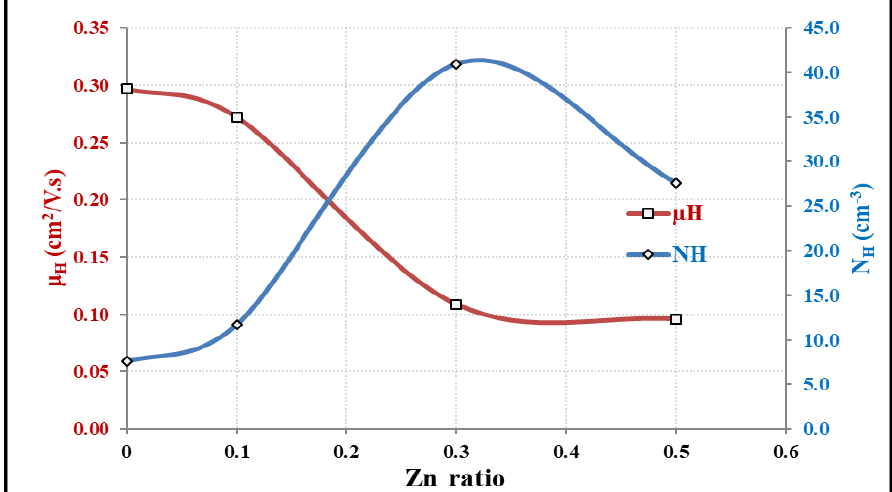
Figure 6: Variation of charge carrier concentration (N